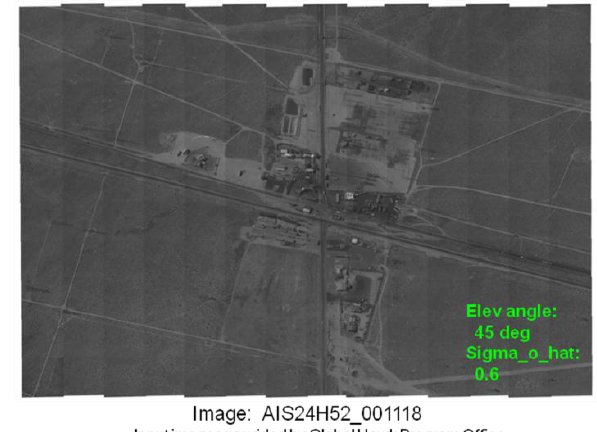
Figure 8. GH UAV output image product, Example 1